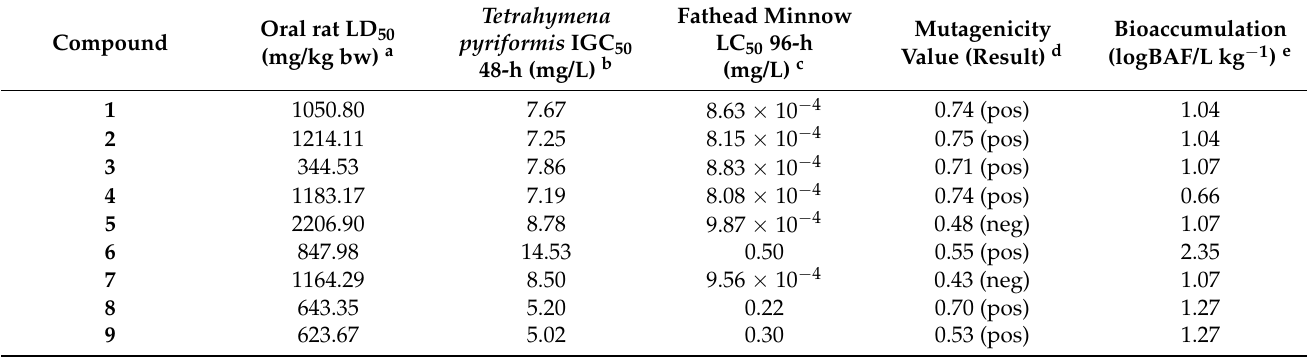
Table 8. Estimated toxicity for nine coumarinyl Schiff